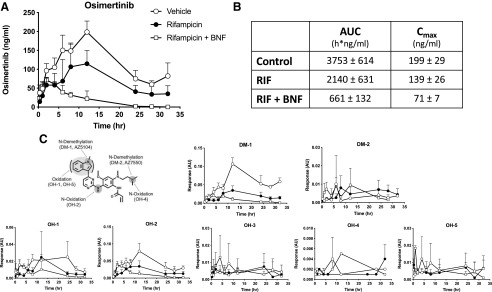
Effect of rifampicin and β-naphthoflavone on osimertinib pharmacokinetics. Adult female 8HUM mice (n = 3) were fed either normal RM1 diet (open circles), RM1 diet with rifampicin (RIF; equivalent dose 10 mg/kg, closed circles) for 3 days or RM1 diet with rifampicin (equivalent dose 10 mg/kg) and administered β-naphthoflavone intraperitoneally (BNF; 80 mg/kg, open squares) daily for 3 days, and on day 4 were administered osimertinib by oral gavage at a dose of 25 mg/kg, and PK profiling of osimertinib (A) and metabolites (B) was carried out as described in Materials and Methods. Osimertinib structure and sites of metabolism in humans (C) are also shown. Data shown are mean ± S.D.